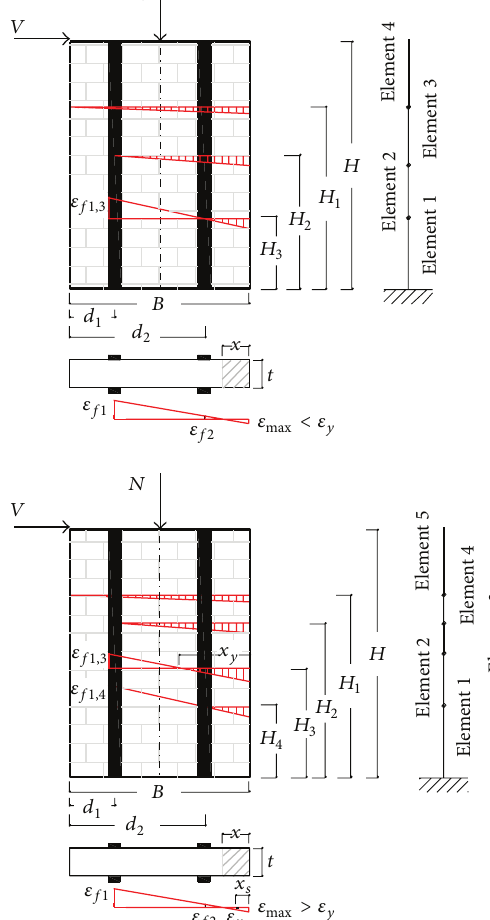
Figure6:FRP-strengthenedpanels:schemesofassemblageofframe elements.